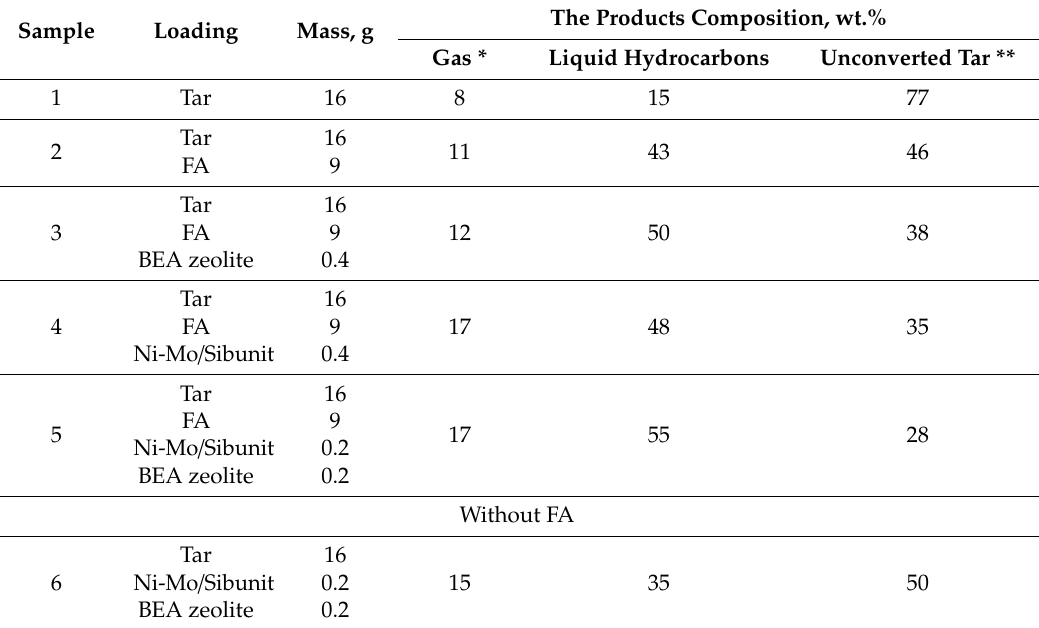
Table 8. The influence of formic acid and catalysts on the tar transformations at 350 ◦ C.